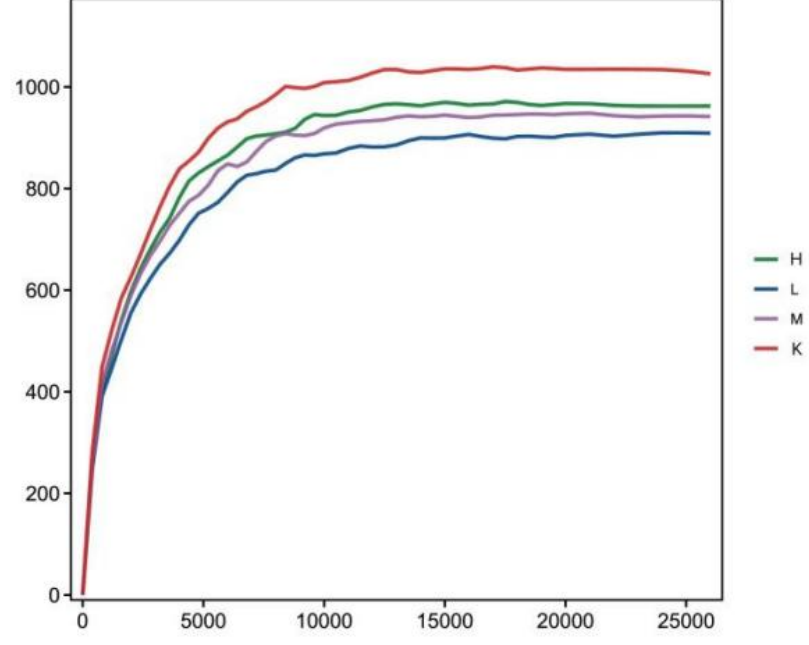
Figure 3. Sample rarefaction curve.